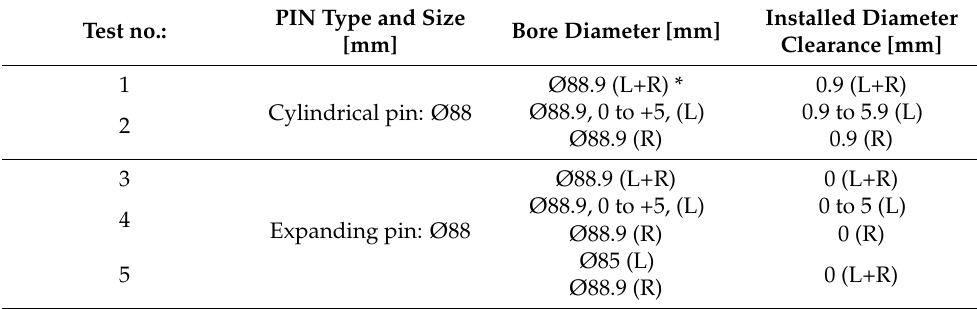
Table 1. Pin type, bore diameter and clearance for tests 1–5.